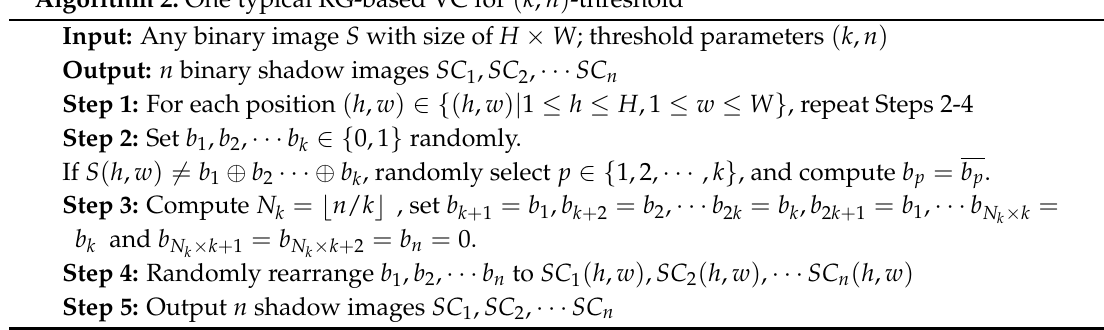
Algorithm 2: One typical RG-based VC for ( k , n )